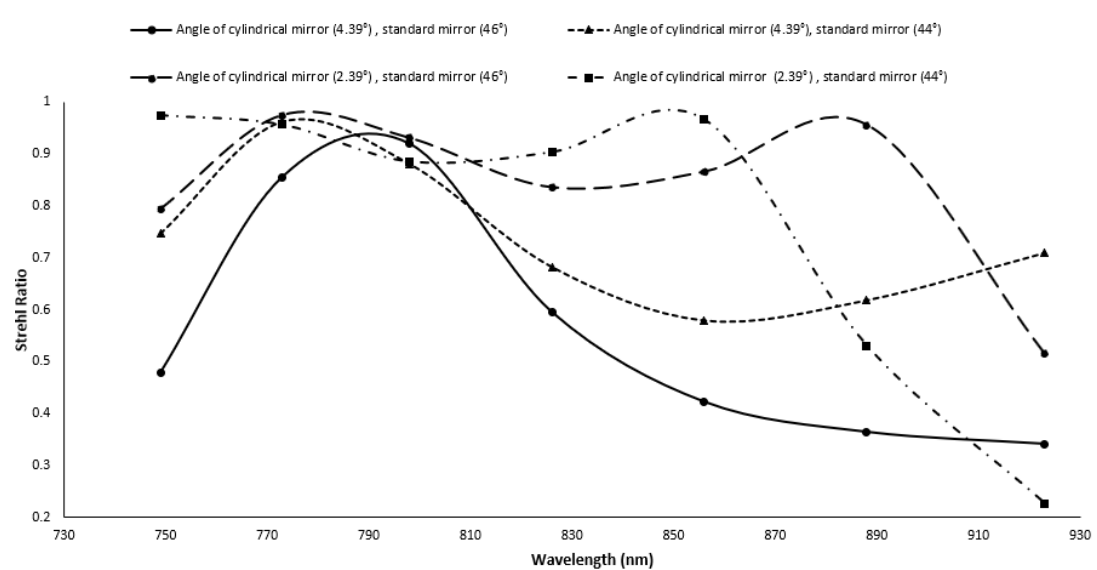
Figure 7. Strehl ratio of the proposed spectrometer for different angles of the optical components.